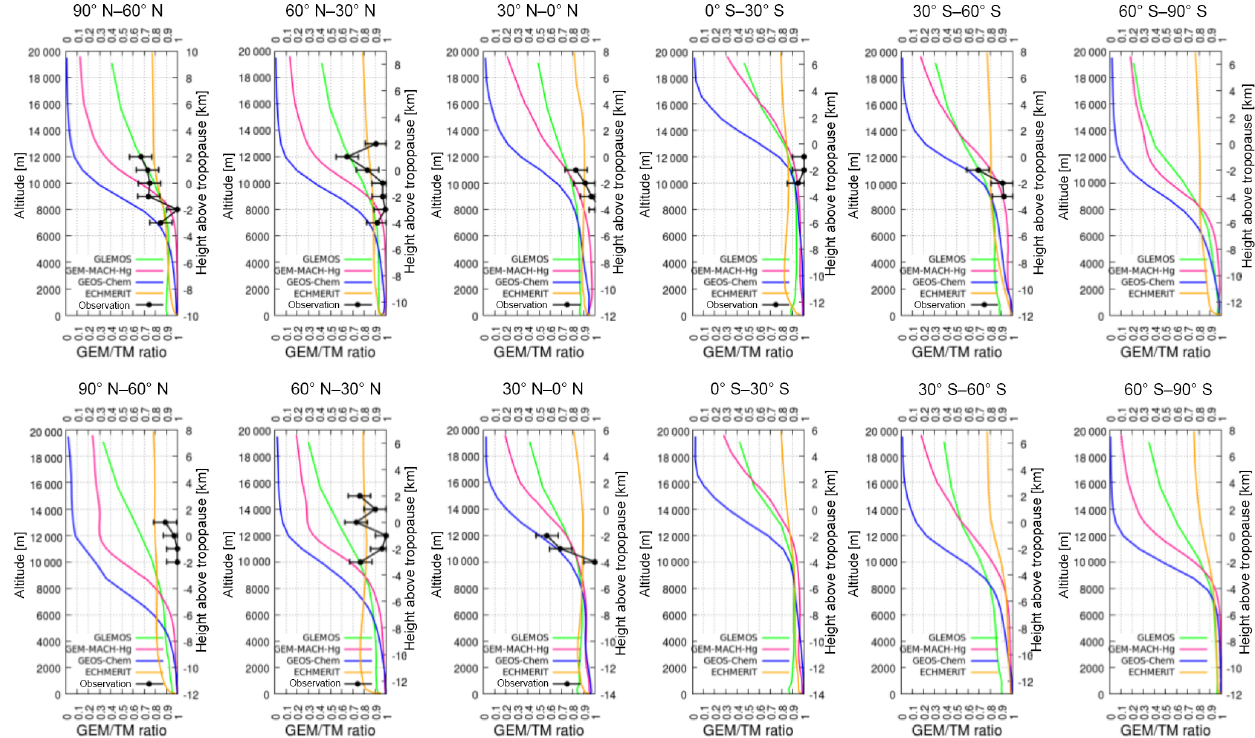
Figure 11. Seasonal vertical profiles of modeled GEM / TM ratios for winter (upper panel) and summer (lower panel). Observations are based on TM and GEM measurements from CARIBIC